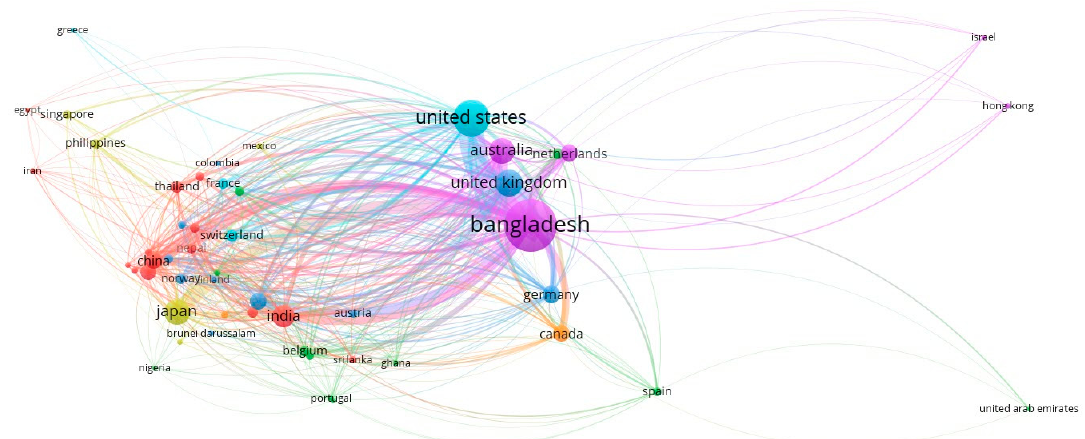
Figure 7. Network map of country co-authorship for Bangladesh water-research-related publications. Countries with a minimum of 10 published and cited articles are included. The map includes 51 countries out of 133 countries in seven clusters. Total link strength of top five countries was as follow: Bangladesh = 2611, USA = 1160, United Kingdom = 699, Australia = 583, India = 413.